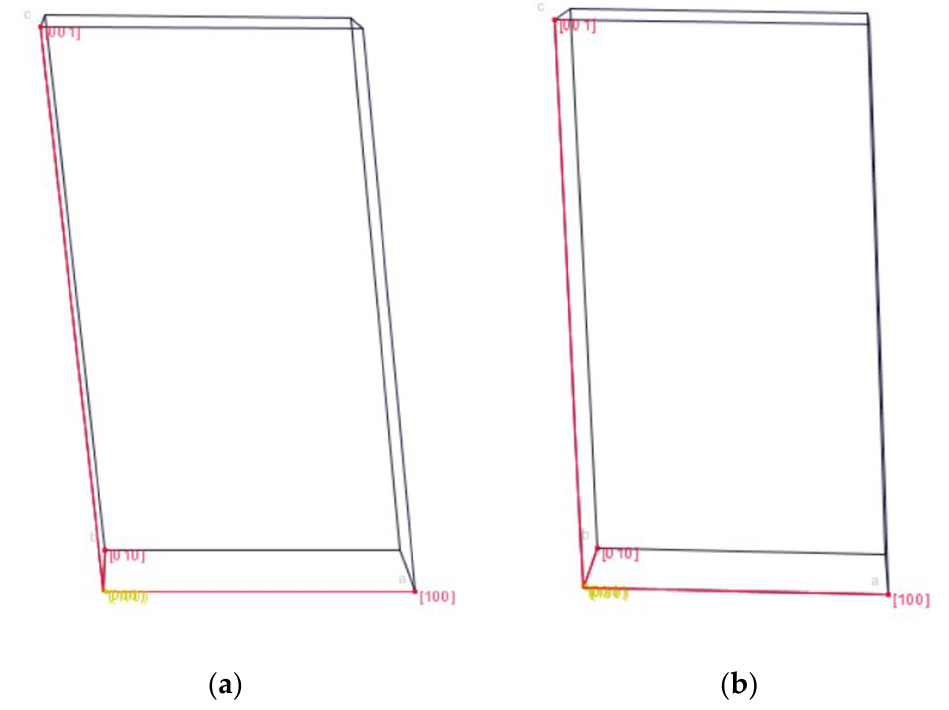
Figure 2. Unit cells of ( a ) posaconazole Form I; ( b ) posaconazole Form-S, as determined via the dichotomy method applied on their XRPD patterns and designed using the JCrystal software. Stability of Posaconazole Form-S through